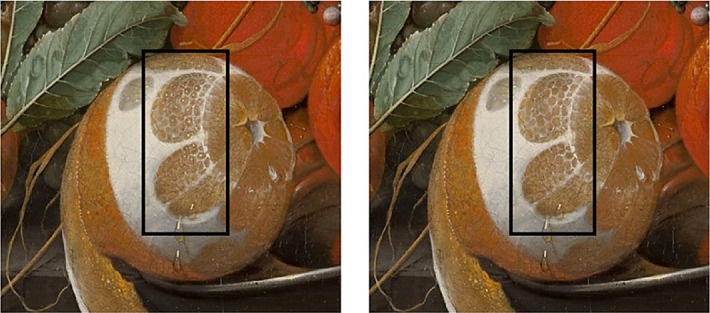
Detail of the stimulus perceived to be the bumpiest. The black box indicates the part that was manually modified by the authors to remove the highlights. (Left) Original painting; (right) modified version without highlights on the side of the pulp. Cornelis de Heem's Fruit Still Life (1670) was downloaded from the online repository of the Mauritshuis, The Hague.